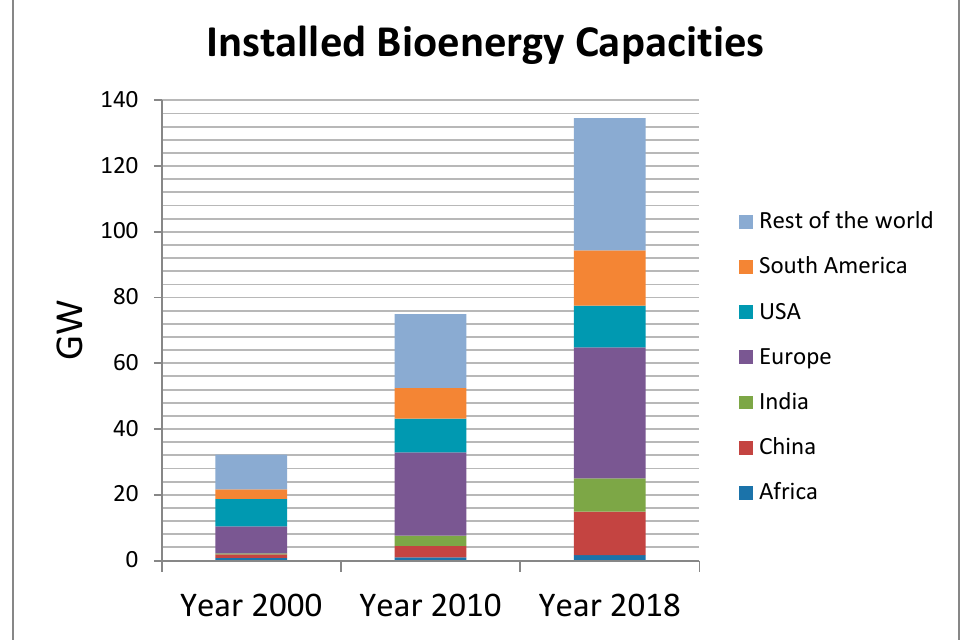
Figure 10. Installed capacities of bioenergy power plants for selected world regions [26].